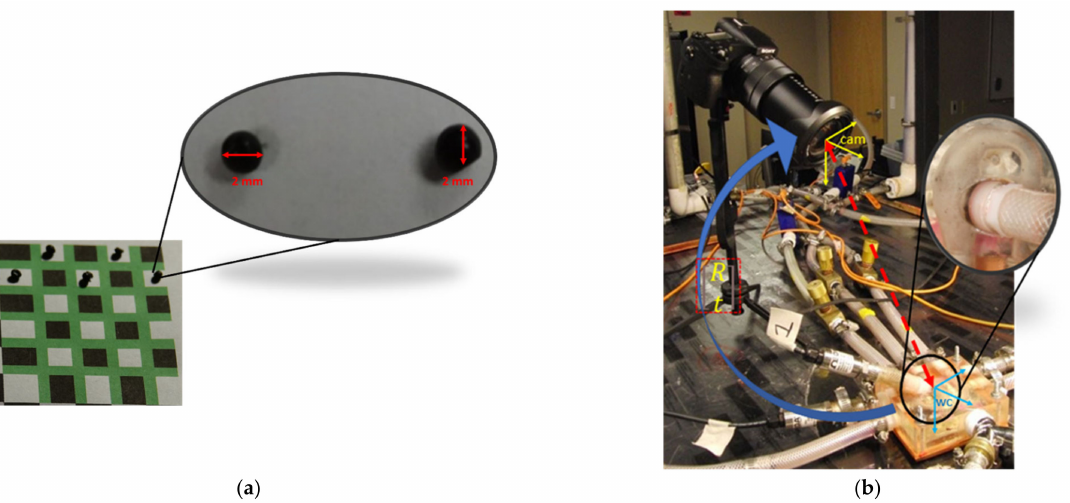
Figure 18. ( a ) A sample 5 × 6 Checkerboard image with the colored pattern used for calibrating the camera; ( b ) Camera resectioning process in the MFL setup by highlighting the region of interest, i.e., MPA